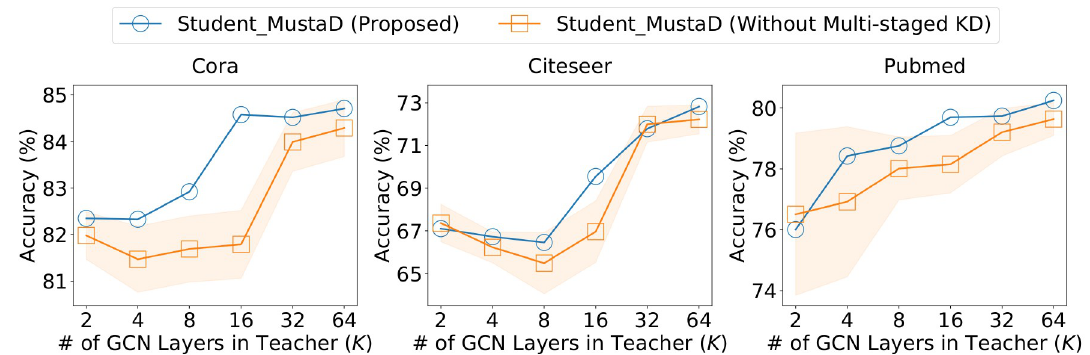
Fig 4. Accuracy of MustaD without the multi-staged knowledge distillation. Note that Student_M USTA D (Without Multi-staged KD) is trained without distilling the knowledge of multi-hop feature representations; i.e., the teacher distills only the knowledge of task prediction to the student. M USTA D with the distillation consistently shows a better performance compared to M USTA D without it.